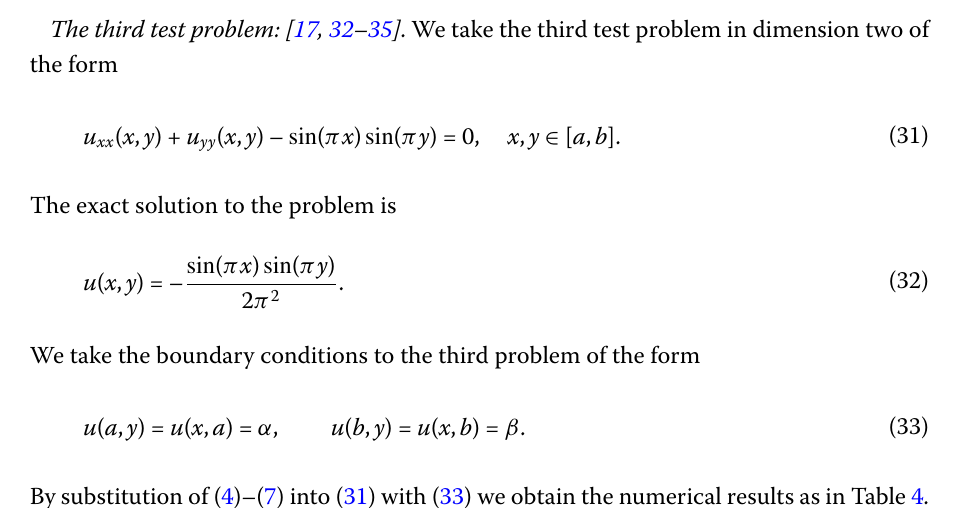
The third test problem: [17, 32–35] . We take the third test problem in dimension two